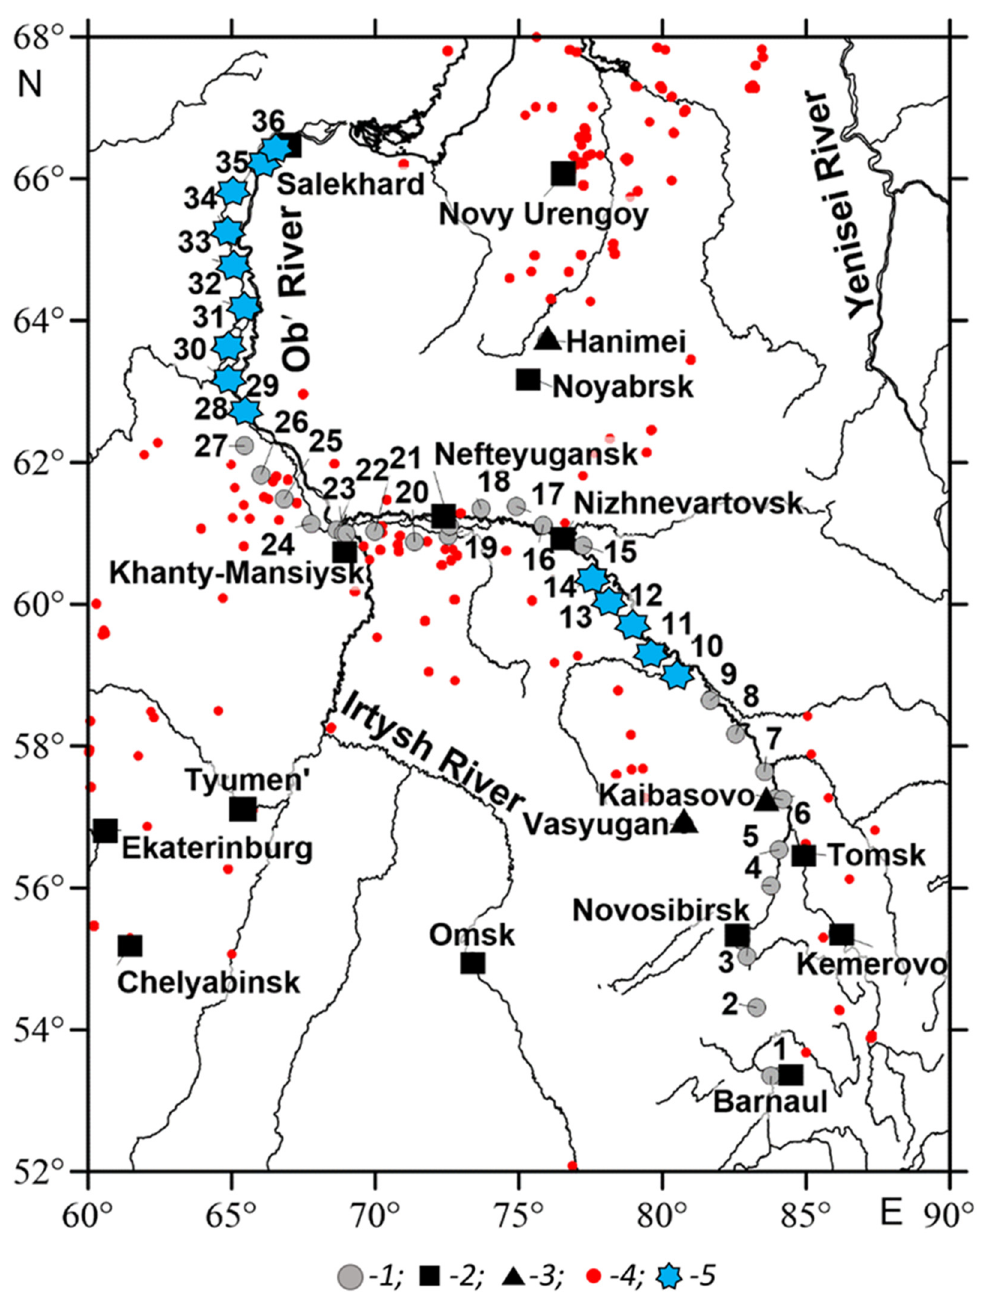
Figure 1. Studied area of the Western Siberian Lowland (WSL): 1—position of the sampling sites; 2—large cities; 3—scientific stations of Tomsk State University; 4—the position of gas flaring from site (https://firms.modaps.eosdis.nasa.gov/download/accessed on 25 July 2020); 5—sampling points taken from the so-called ‘zimnik’ which has no solid cover and is used only several months per year, with rather low traffic density.